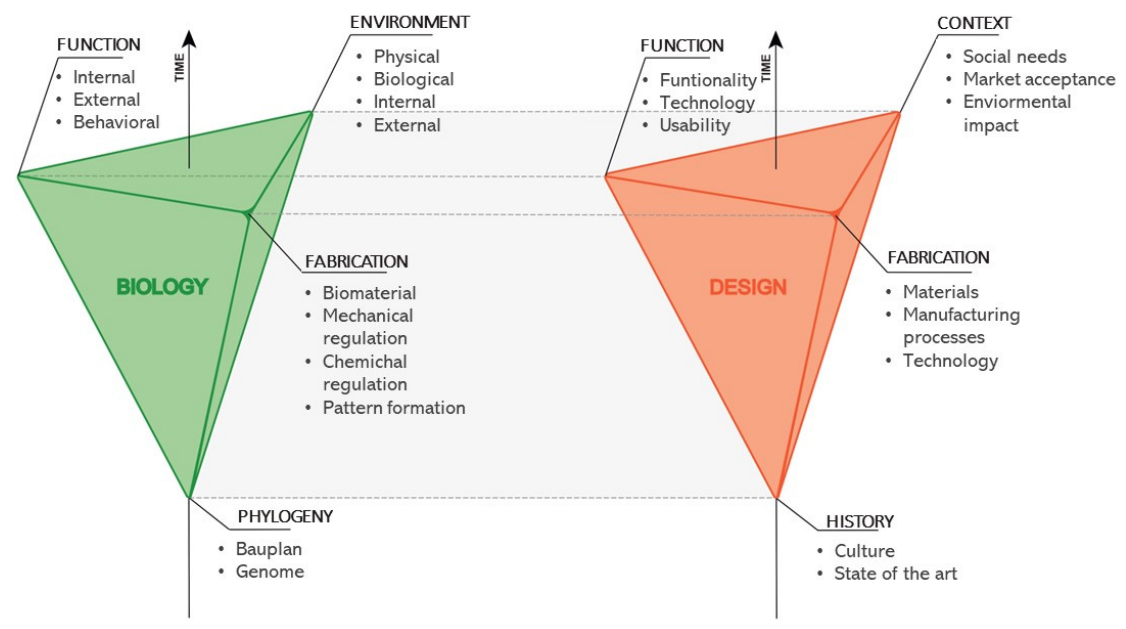
Figure 1. Morphodynamics in biology and design. Conceptual framework of evolutionary constraints in biology and design. Adapted from: Seilacher and Gishlick, 2014.